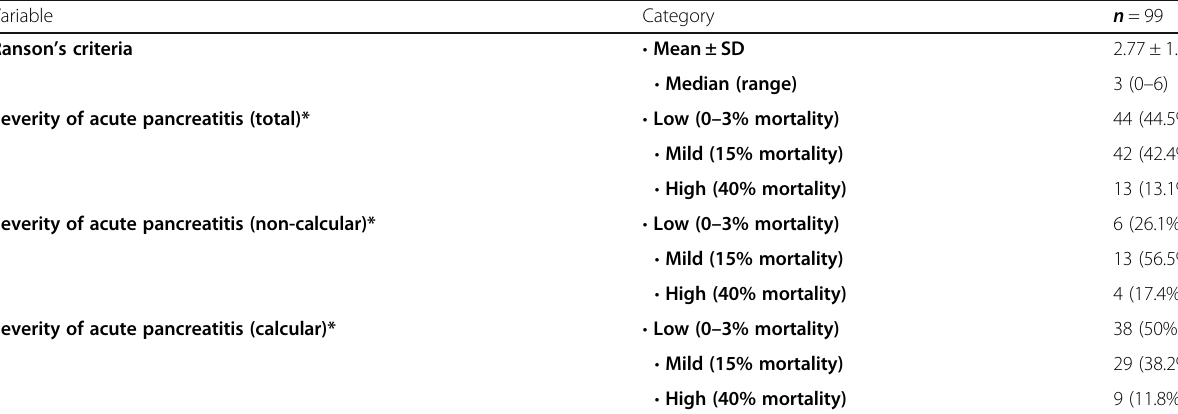
Table 5 Severity of acute pancreatitis according to Ranson ’ s score Variable